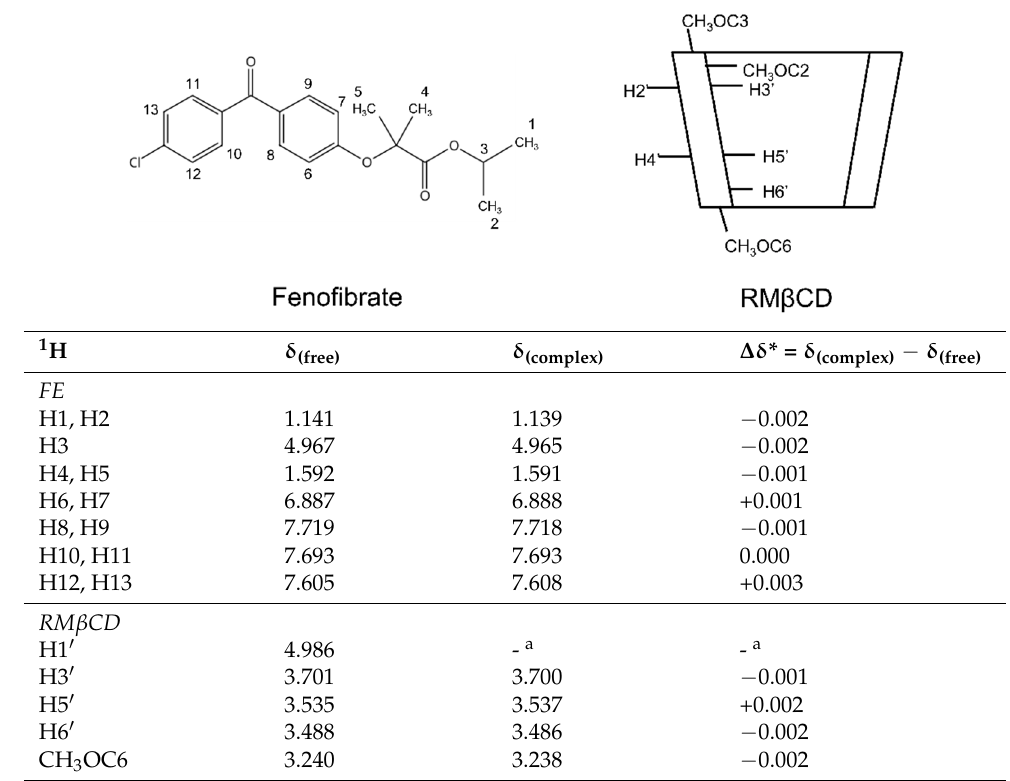
Table 3. The 1 H-chemical shifts of FE alone and in the presence of RM β CD.